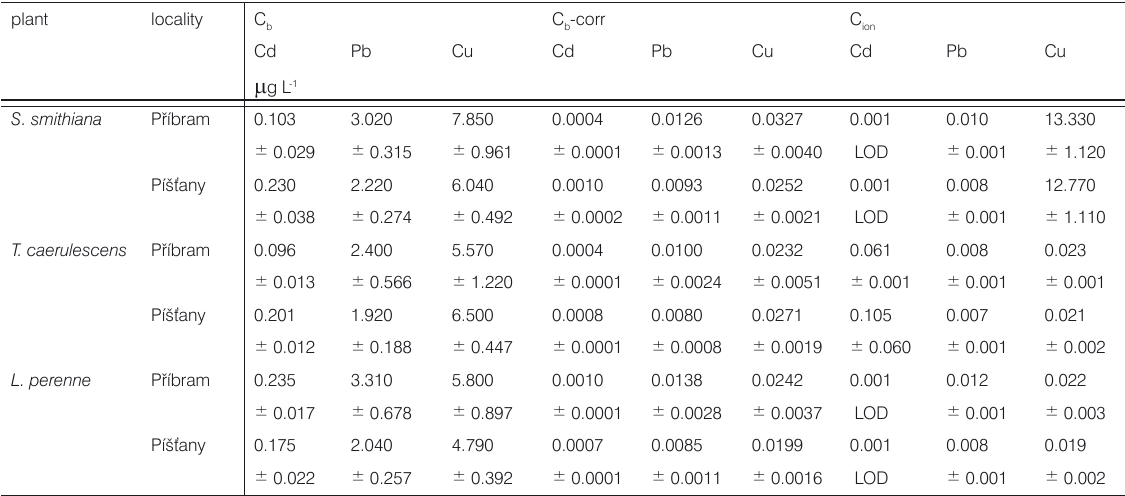
Table 6. The comparison among C (available content of heavy metals determined by DGT, equation (1)), C b cumulation according to: